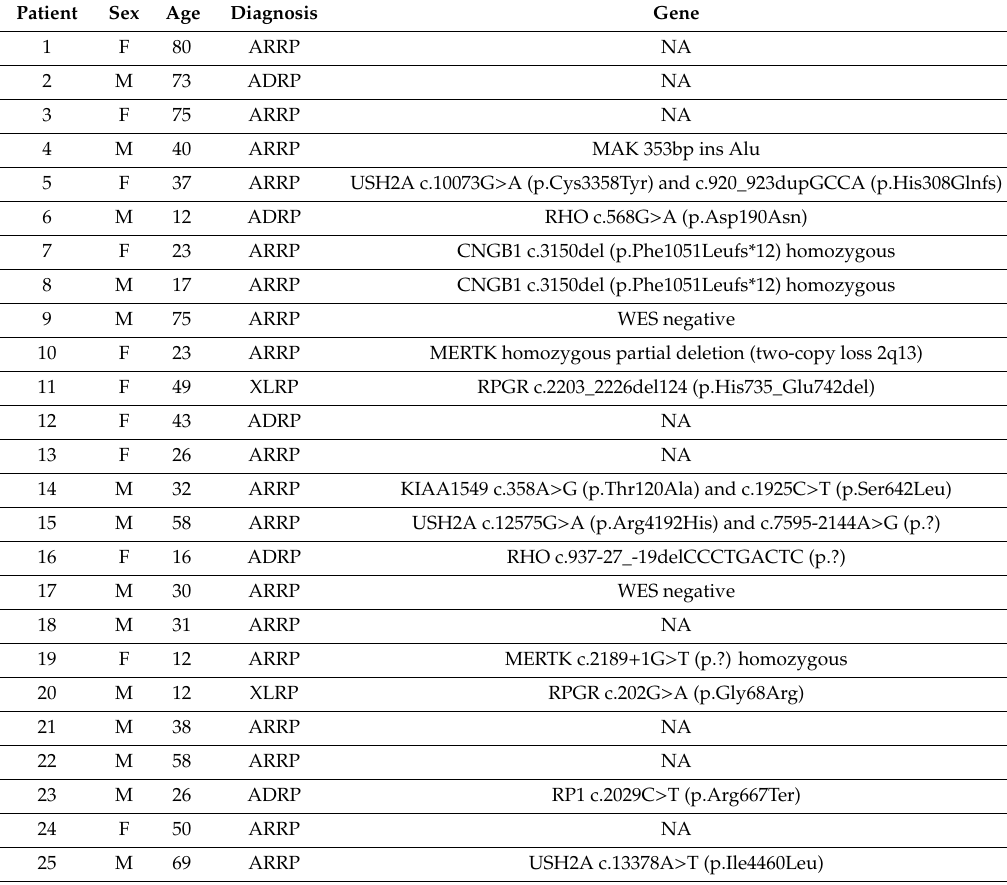
Table 1. Demographic and genetic characterization of study patients.